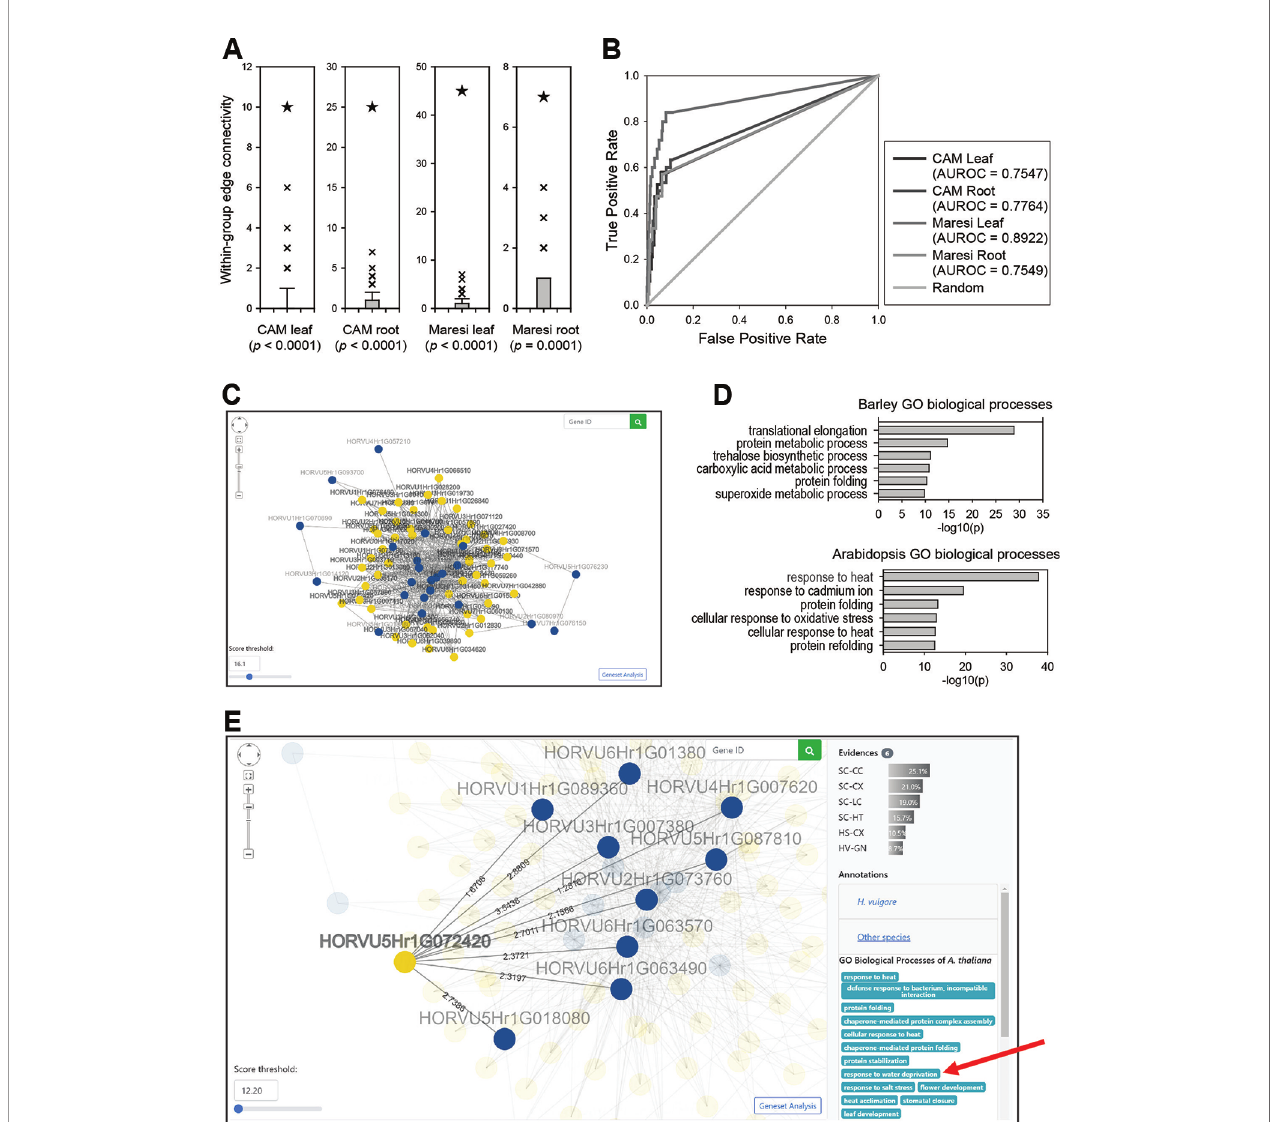
FIGURE 3 | Predictions for drought response genes using BarleyNet. (A) Within-group edge connectivity was computed for drought response genes identi fi ed from leaves and roots of two cultivars, Maresi and Cam/B1/CI (referred to as CAM), and 1,000 random gene sets of the same size. Asterisks indicate the within-group edge count of each trait-associated gene set in BarleyNet. Within-group edge counts for drought response genes by BarleyNet were signi fi cantly higher than those by random gene sets ( P < 0.001 by a binomial test). (B) AUROC analysis for the same drought response genes. (C) Screenshot of network viewer, which visualizes a network of drought response genes identi fi ed from differentially accumulated proteins in CAM roots (guide genes; blue nodes) and their 50 closest neighbors (candidate genes; yellow nodes) in BarleyNet. The number of neighbors in the network can be controlled by selecting a score threshold at the bottom left area. Clicking the button at the right bottom area allows gene set enrichment analysis for the selected neighbors. (D) Enriched GOBP terms among the 50 closest neighbors to the drought response genes, based on barley (upper plot) and Arabidopsis GOBP annotations (lower plot). (E) Screenshot of the network viewer highlighting a selected candidate gene (yellow node), HORVU5Hr1G072420. The viewer also highlights its connected user-input guide genes (i.e., drought response genes; blue nodes) and edges with their log likelihood scores. The right-side panel shows related information such as data sources that support the prediction of HORVU5Hr1G072420 as a candidate gene (Evidences) with relative contributions (% of total prediction score), as well as GOBP annotations for the candidate gene. Notably, the selected candidate gene HORVU5Hr1G072420 was annotated for “ response to water deprivation ” in Arabidopsis GOBP annotations (marked by a red